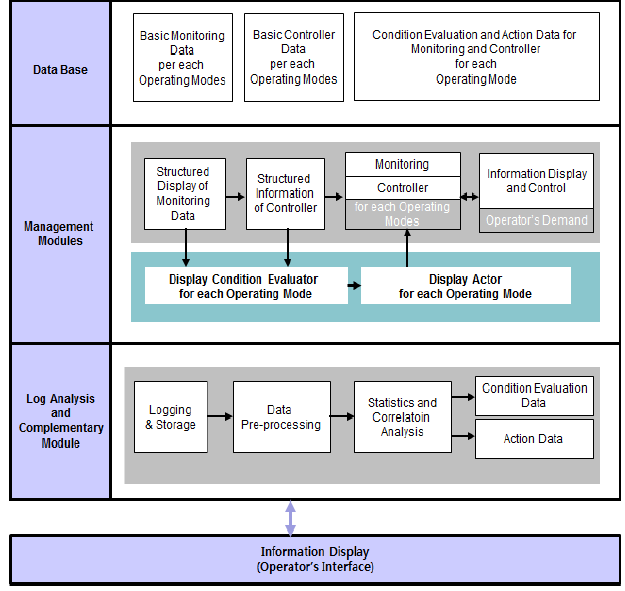
Fig. 1. Method for Monitoring and Controller Display for each Operation Mode based on Log Analyses of Operator